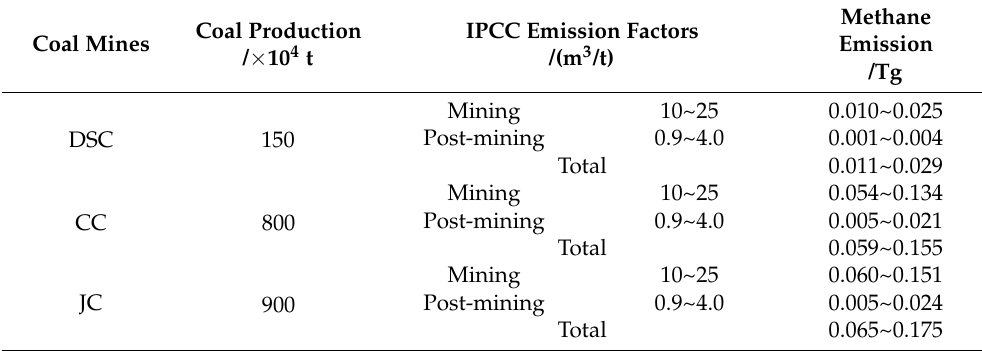
Figure 6. Location of the study coal mine area in China. Table 1. Methane emission from coal mining and post-mining for the coal mines.